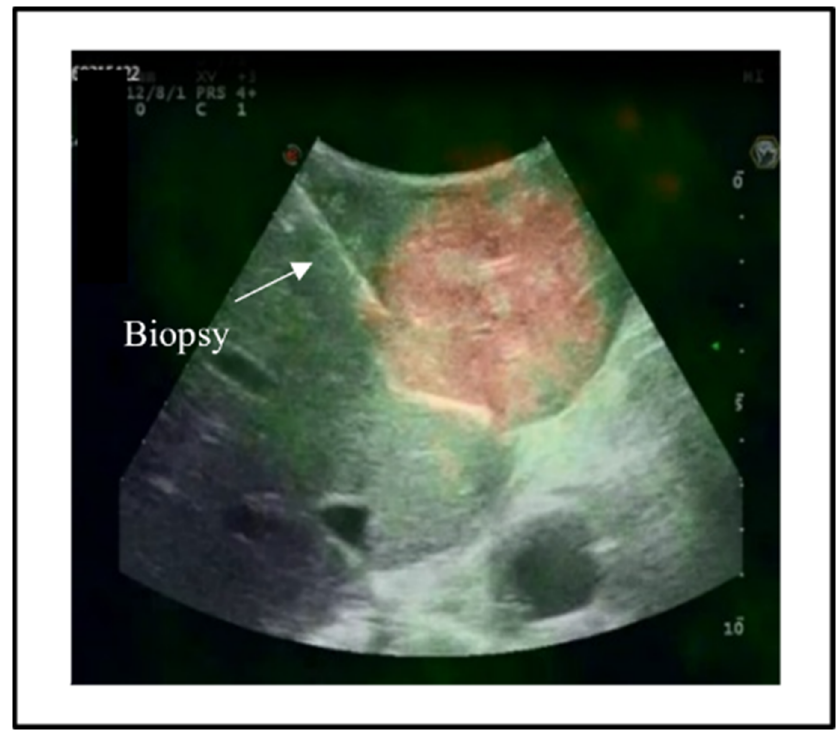
Figure 2. IOUS-guided biopsy of the tumour areas having different uptake at PET-CT.